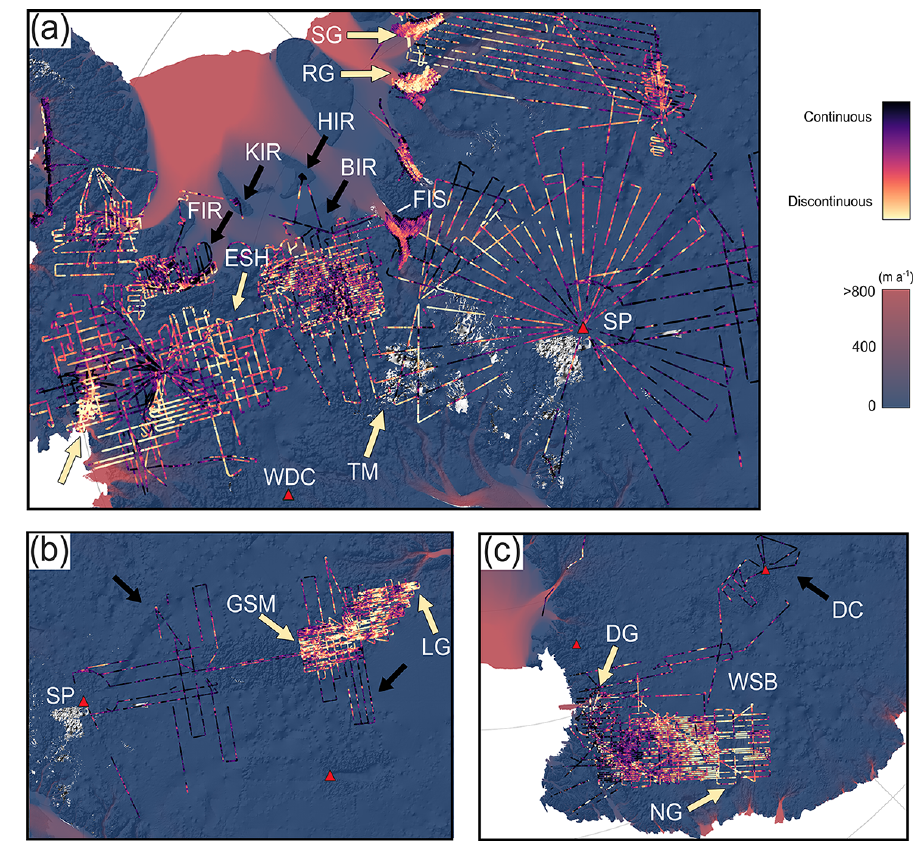
Figure 9. Zoomed-in sections of the Internal Layer Continuity Index (ICLI) shown in the black-bordered rectangles in Fig. 8. The basemap datasets and colour scales are the same as in Fig. 8. (a) ILCI results over the WAIS (including Pine Island Glacier, Rutford Ice Stream, Institute–Möller Ice Stream, and Foundation Ice Stream) and bottleneck with the EAIS (including the South Pole, Pensacola Mountains and Slessor Glacier), (b) ILCI results for the AGAP survey over East Antarctica’s Dome A and South Pole, (c) ILCI results for the WISE- ISODYN survey over East Antarctica’s Wilkes Subglacial Basin and Dome C. Arrows refer to locations mentioned in the text, with black arrows highlighting examples of high-layer continuity and yellow arrows low-layer continuity. As per Fig. 8, the red triangles correspond to existing deep ice cores located near the BAS radar surveys. Abbreviations correspond to locations mentioned in the text, as follows: BIR (Bungenstock Ice Rise); DC (Dome C); DG (David Glacier); ESH (Ellsworth Subglacial Highlands); FIR (Filchner Ice Rise); FIS (Foundation Ice Stream); GSM (Gamburtsev Subglacial Mountains); HIR (Henry Ice Rise); KIR (Korff Ice Rise); LG (Lambert Glacier); NG (Ninnis Glacier); RG (Recovery Glacier); SG (Slessor Glacier); SP (South Pole); TM (Transantarctic Mountains); WDC (WAIS Divide Core); WSB (Wilkes Subglacial